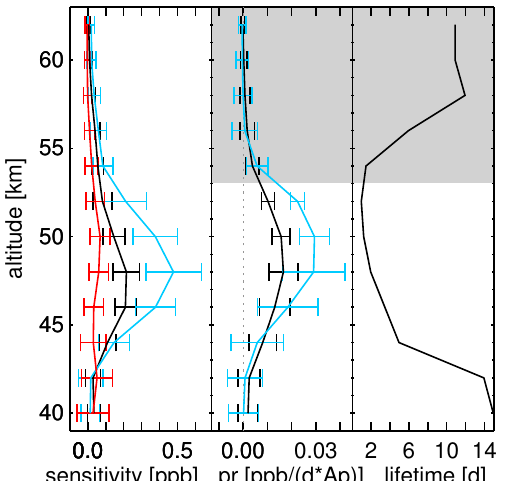
Fig. 7. Left: Altitude-dependent sensitivity of 1 NO 2 on the con- ditions of epoch types 1/2/3 shown in black/blue/red, respec- tively. Middle: Altitude-dependent production rate pr or epoch type 1/2 shown in black/blue, respectively. Right: Altitude-dependent 1 NO 2 lifetime at night. All quantities were determined at 65 ± 5 ◦ N geomagnetic latitude. The error bars show the 1 σ range. The shad- owed area marks the altitudes, where the determination of the life- time is not reliable.